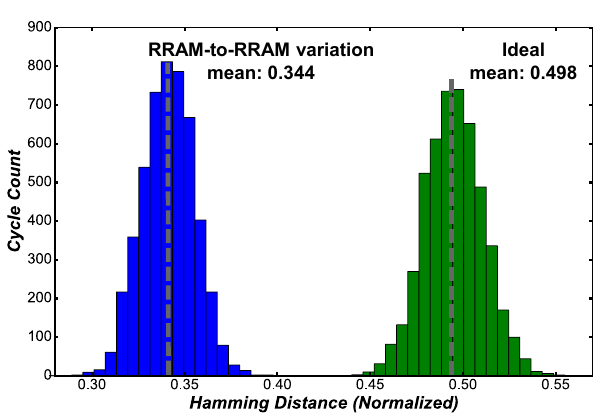
Figure 21: The simulated inter-configuration hamming distance with and without the RRAM-to-RRAM variation using the multiple SET algorithm.